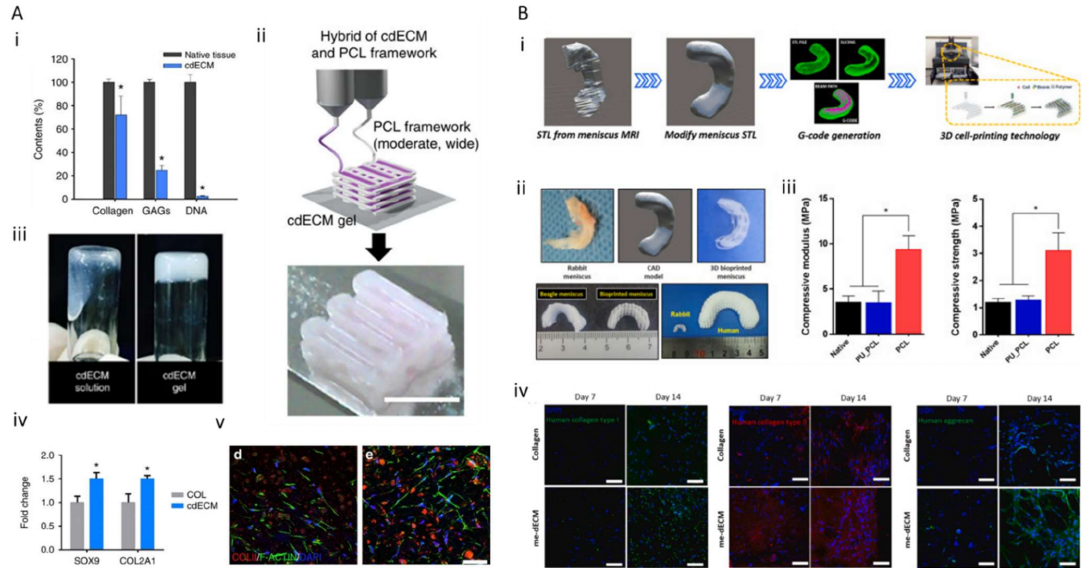
Figure 4. Three-dimensional bioprinting of cartilage. ( A ) ( i ) Biochemical analysis of cdECM bioink; ( ii ) 3D bioprinted cartilage construct; ( iii ) sol-gel transition of cdECM; ( iv , v ) relative mRNA expression of cartilage-specific ECM (scale: 50 µ m; *, p < 0.05). ( B ) ( i , ii ) 3D bioprinted implantable meniscus graft; ( iii ) comparison of the compressive modulus and strength of 3D bioprinted meniscus; ( iv ) comparison of immunostaining of type I collagen, type II collagen, and aggrecan in collagen and me-dECM groups on day 7 (*, p < 0.05). Reproduced with permission from Refs. [71,124] with slight changes